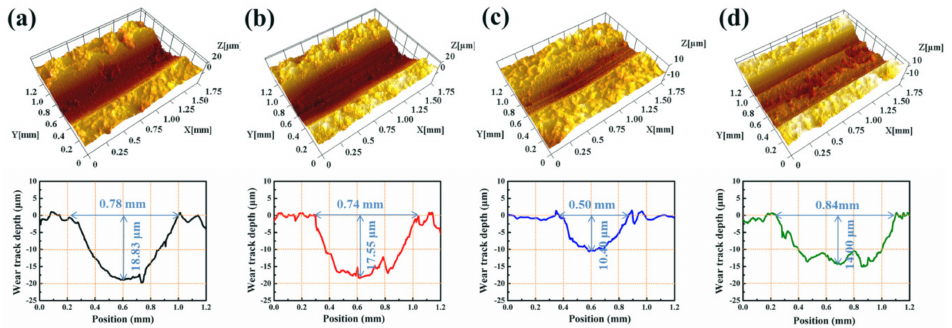
Figure 8. 3D morphologies of wear tracks and cross-sections, ( a ) S-C0, ( b ) S-C2, ( c ) S-C4, and ( d ) S-C6.